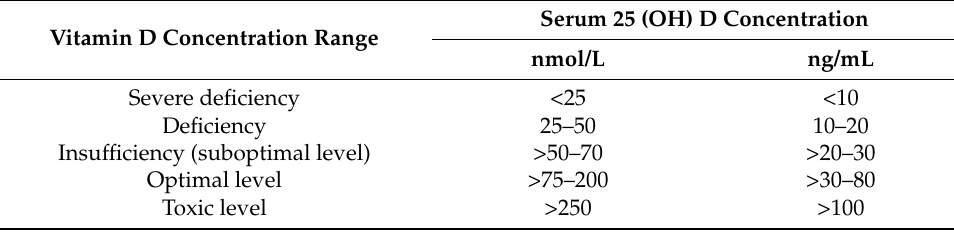
Table 1. Terminology of vitamin D concentration